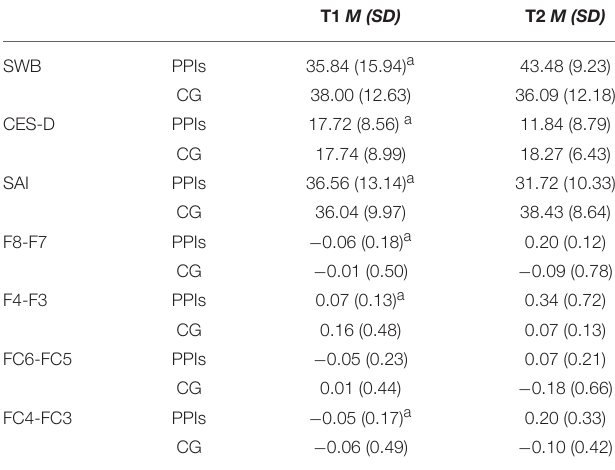
TABLE 2 | Means ( M ), Standard Deviations ( SD ) for subjective well-being, depression and anxiety at T1, T2 for the intervention group ( n = 25) and control group ( n = 23), and the results of the repeated measures ANOVA after data were split by group.